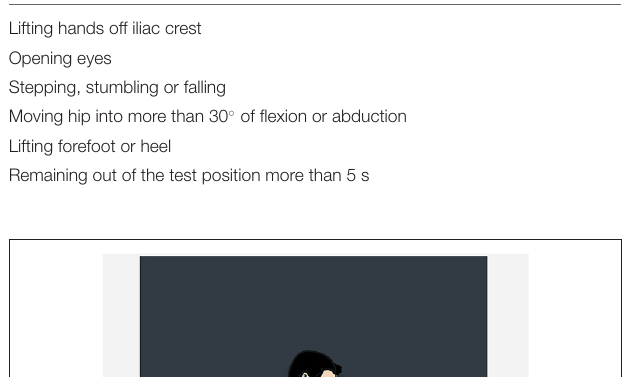
TABLE 2 | Single leg stance test on firm surface derived from the Balance Error Scoring System (BESS). Balance errors assessed by the examiner